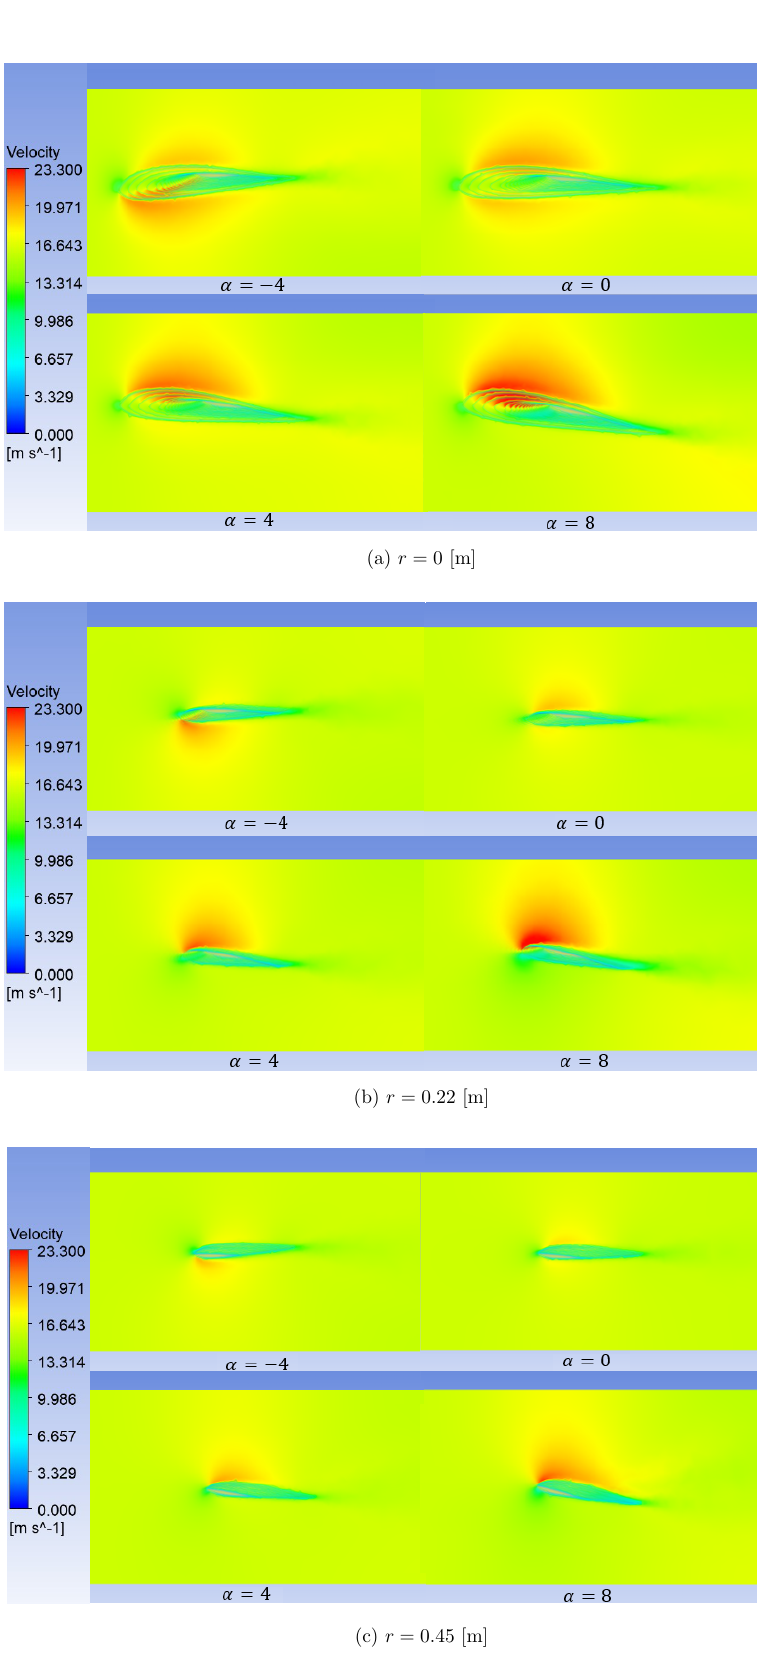
Figure 18. Velocity contours at different angles of attack: ( a ) local radius r = 0 [m], ( b ) local radius r = 0.22 [m] and ( c ) local radius r = 0.45 [m]